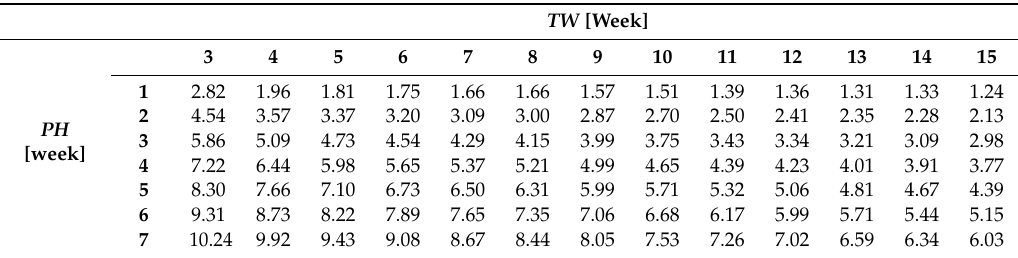
Table 4. Mean relative prediction error ( MRPE ), in percentage, for di ff erent combinations of time window ( TW ) and prediction horizon ( PH ) sizes, measured in weeks, when applying the dynamic linear regression (DLR)